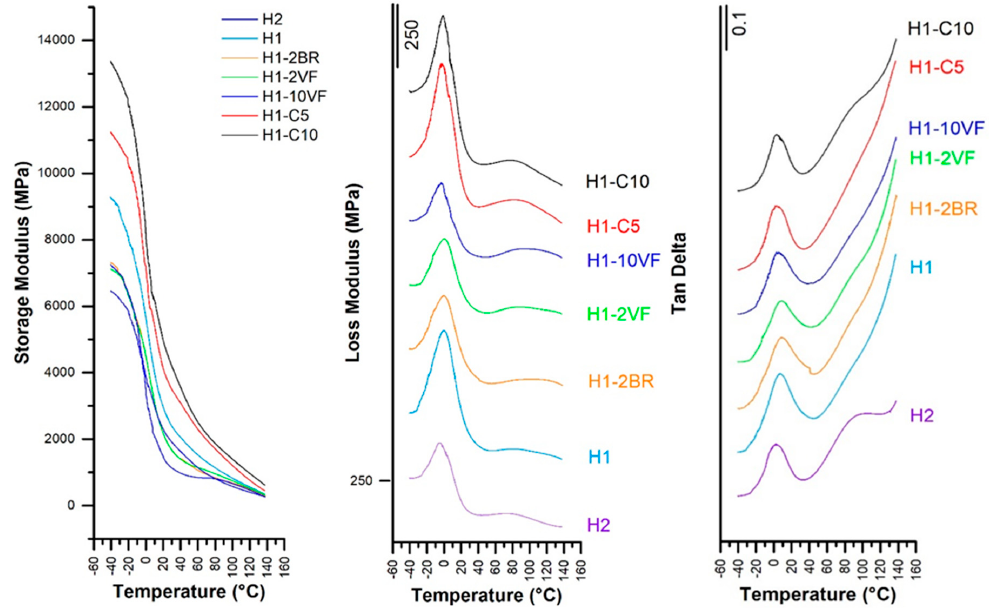
Figure 5. Storage modulus, loss modulus and tan δ evolution.